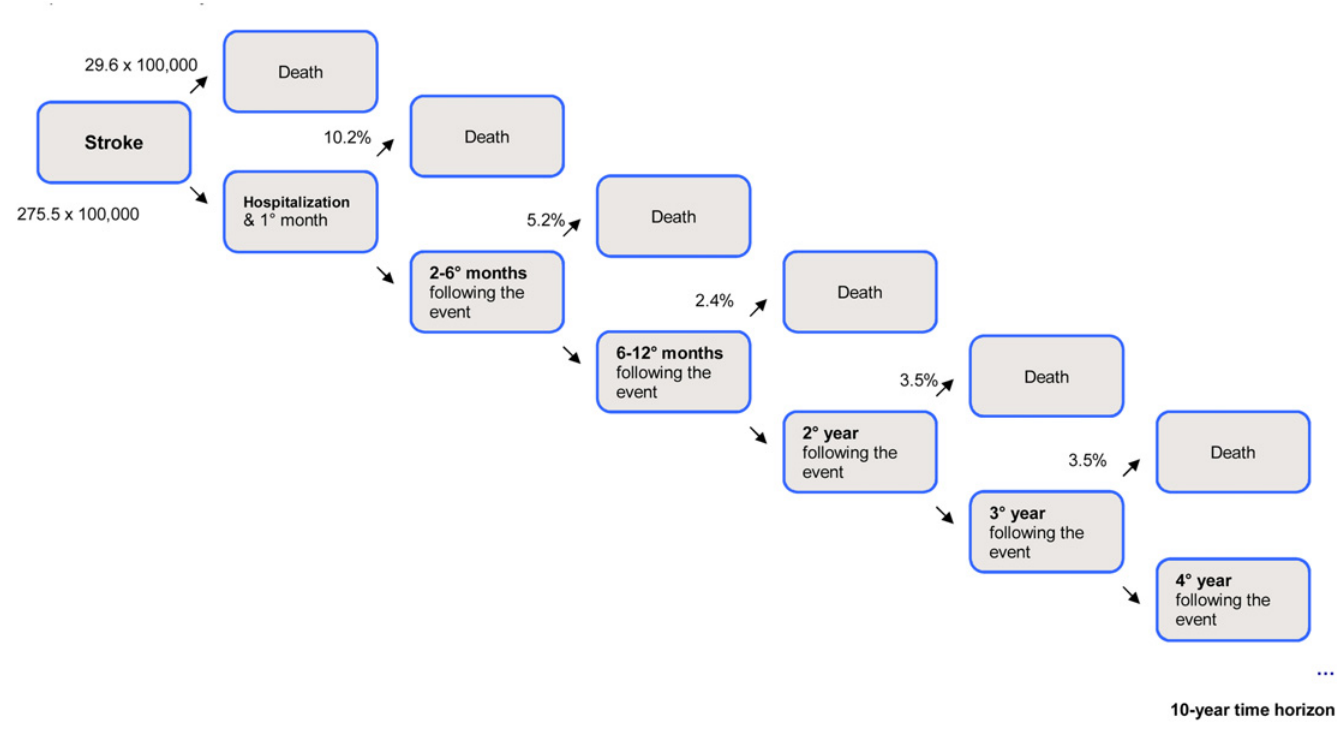
Fig 3. Schematic representation of first 4 years ’ model: